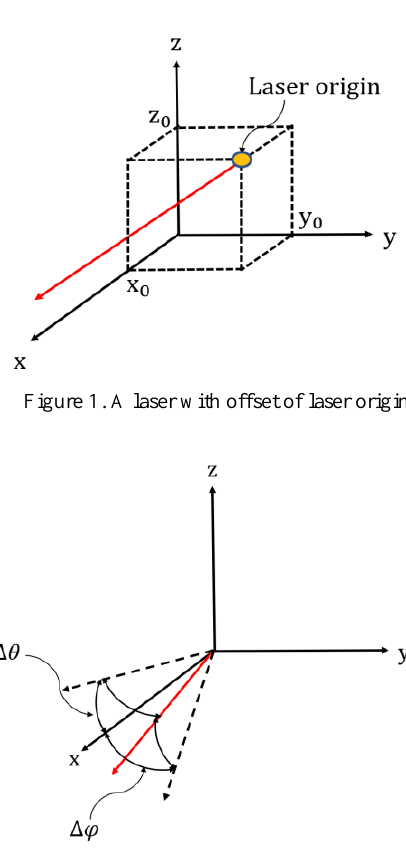
Figure 2. A laser with offsets of laser